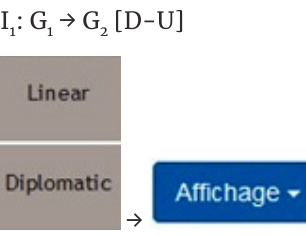
The Hot spot/Text link group (H implementation, was deleted and will be considered for future, more advanced